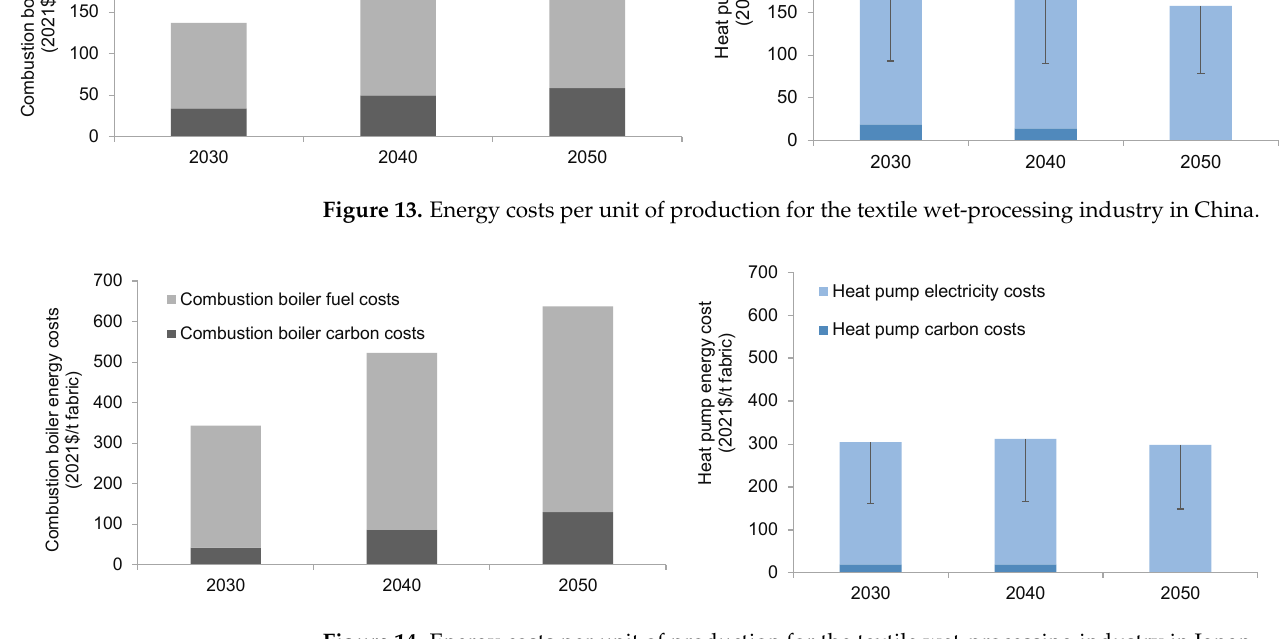
Figure 14. Energy costs per unit of production for the textile wet-processing industry in Japan.